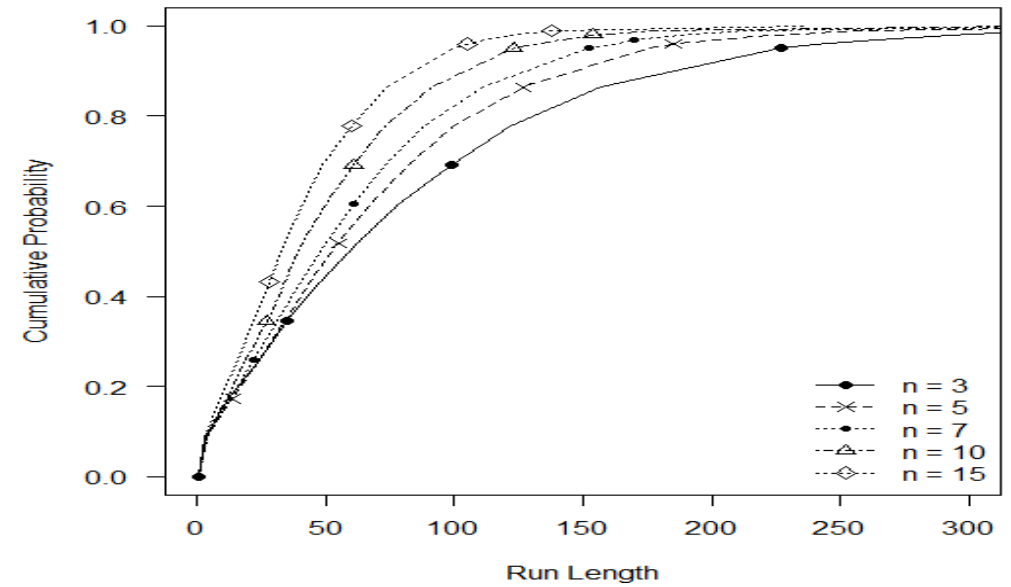
Figure 3. Run-length curves for different levels of 𝑛 when 𝜆 = 0.05 and 𝛿 𝑡 = 1.05.